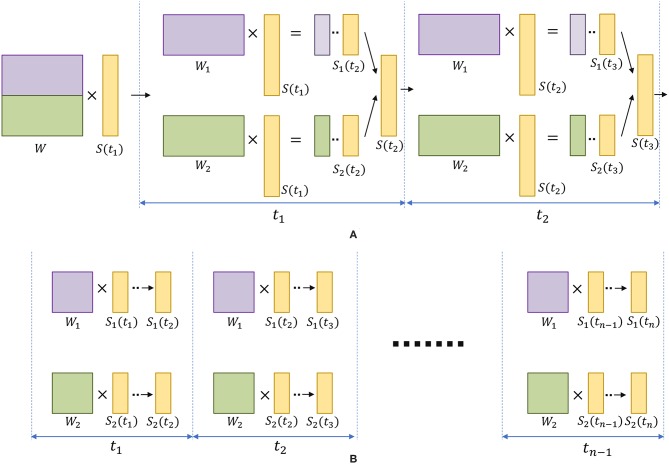
(A) The division of matrix-vector multiplication using row-wise striped matrix decomposition, for the single liquid baseline LSM. Note that during each time step, the generated S1 and S2 vectors need to be concatenated to form the S vector (represents the spiking activity of the liquid), which requires communication between cores. (B) The “embarrassingly parallel” nature, and the reduced amount of operations in the ensemble approach allows two small liquids to run in parallel as two independent tasks, until the end of the last simulation time step tn.